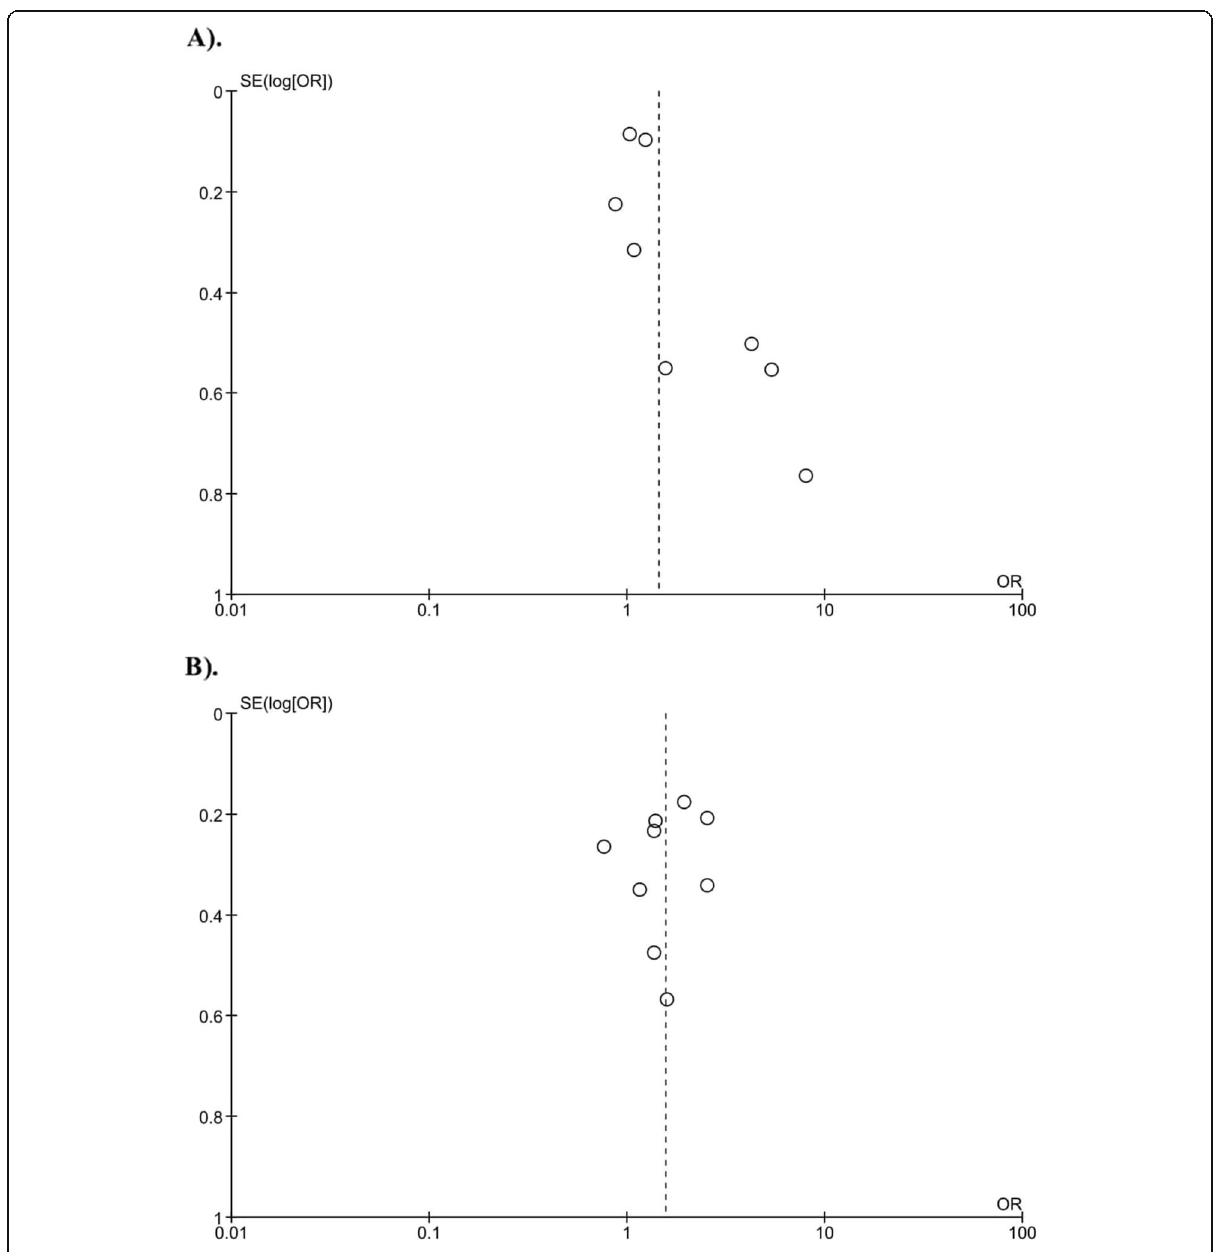
Fig. 4 Funnel plot of the association between the risk of urilithiasis and ( a ) R990G and ( b ) A986S gene